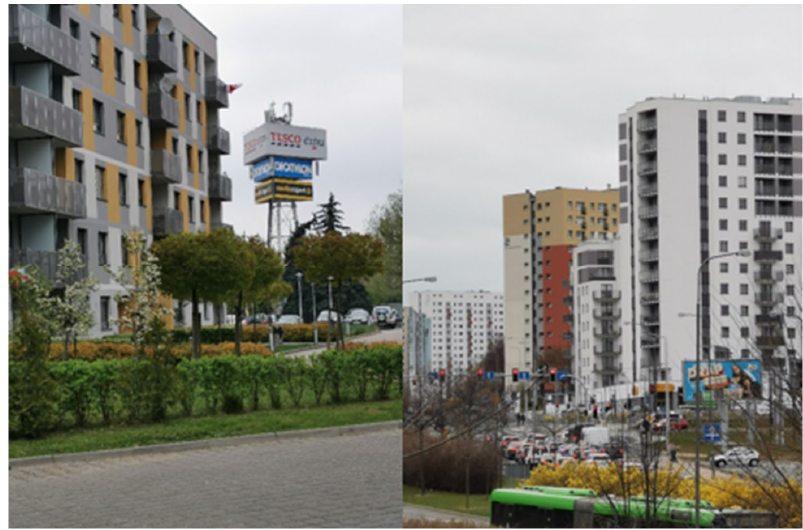
Figure 2. Winogrady Estate, Pozna ń (Roman Andrzejak 2022).